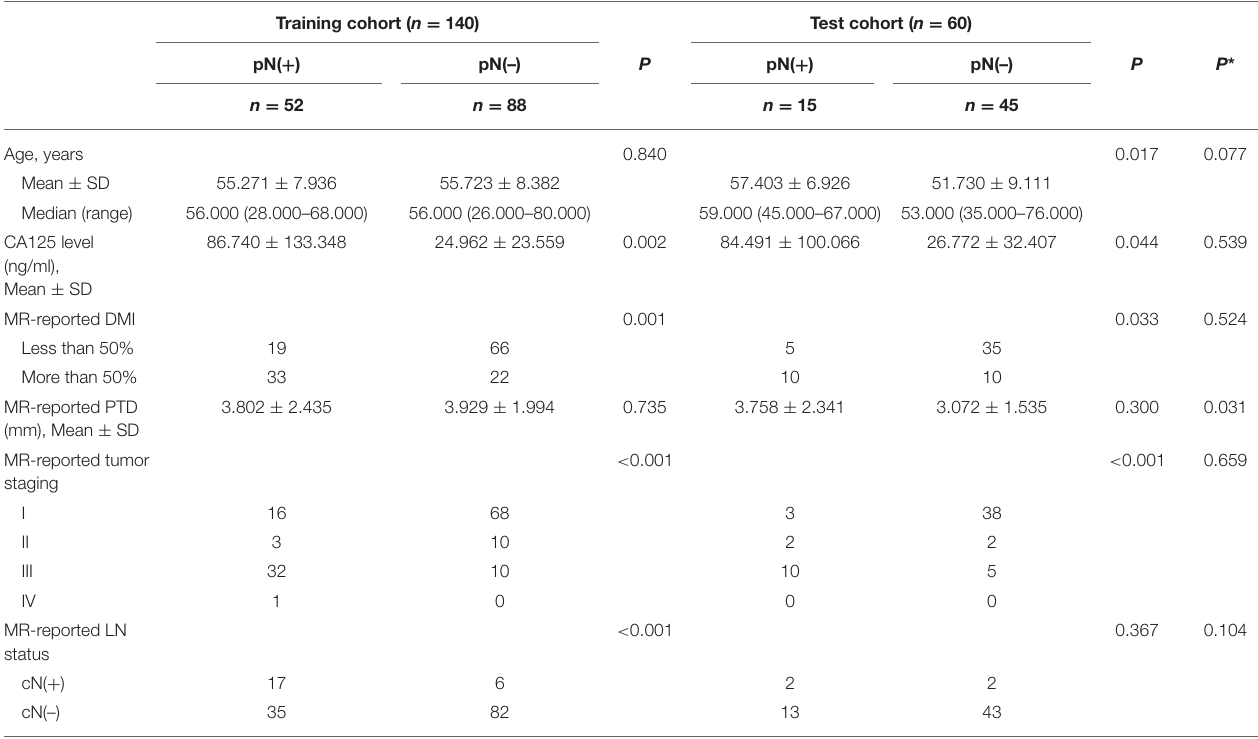
TABLE 1 | Baseline characteristics of the training and test cohorts.